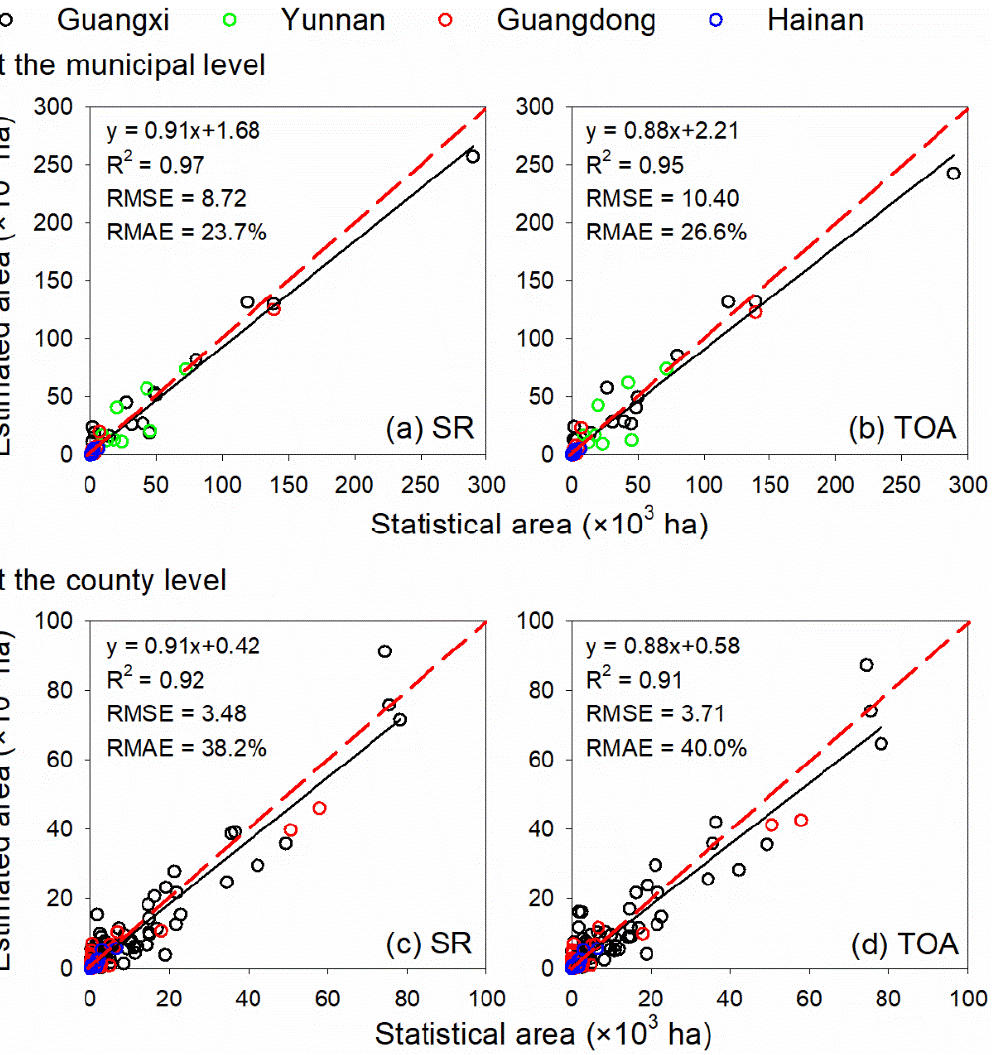
Figure 7. Correlations between the estimated and agricultural statistical planted areas of sugarcane at the ( a , b ) municipal and ( c , d ) county level in China in 2019. Correlations between the estimated and agricultural statistical planted areas of sug- arcane exhibited differently in different provinces at the municipal and county levels. At the municipal level, the R 2 ranged from 0.80 (Yunnan) to 0.99 (Guangdong) and the RMAE ranged from 19.4% (Guangxi) to 42.7% (Hainan) with SR data. And the R 2 ranged from 0.73 (Yunnan) to 0.98 (Guangdong) and the RMAE ranged from 21.4% (Guangxi) to 43.2% (Hainan) with TOA data (Figure 8a). At the county level, the R 2 ranged from 0.82 (Hainan) to 0.96 (Guangdong) and the RMAE ranged from 35.7% (Guangxi) to 51.1% (Guangdong) with SR data. And the R 2 ranged from 0.83 (Hainan) to 0.94 (Guangdong) and the RMAE ranged from 37.1% (Guangxi) to 55.0% (Guangdong) with TOA data (Figure